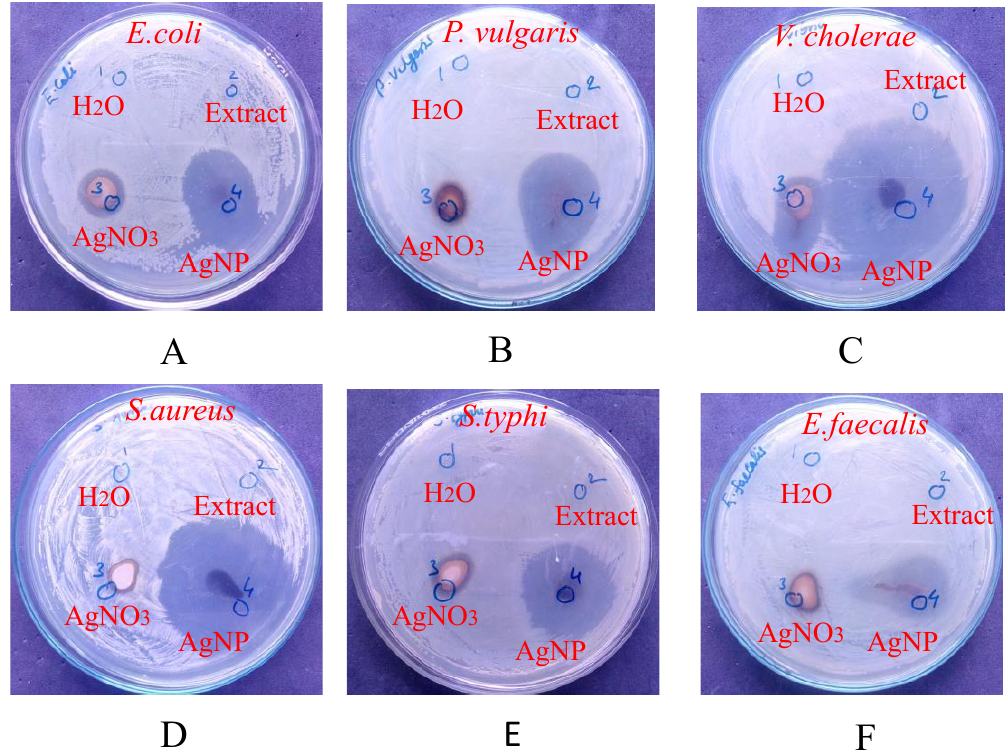
Fig. 7. The image represents the antibacterial activity of silver nanoparticles, silver nitrates and extract against the bacteria Table 2. The table 2 represents the antibacterial activity of silver nanoparticles, silver nitrates and